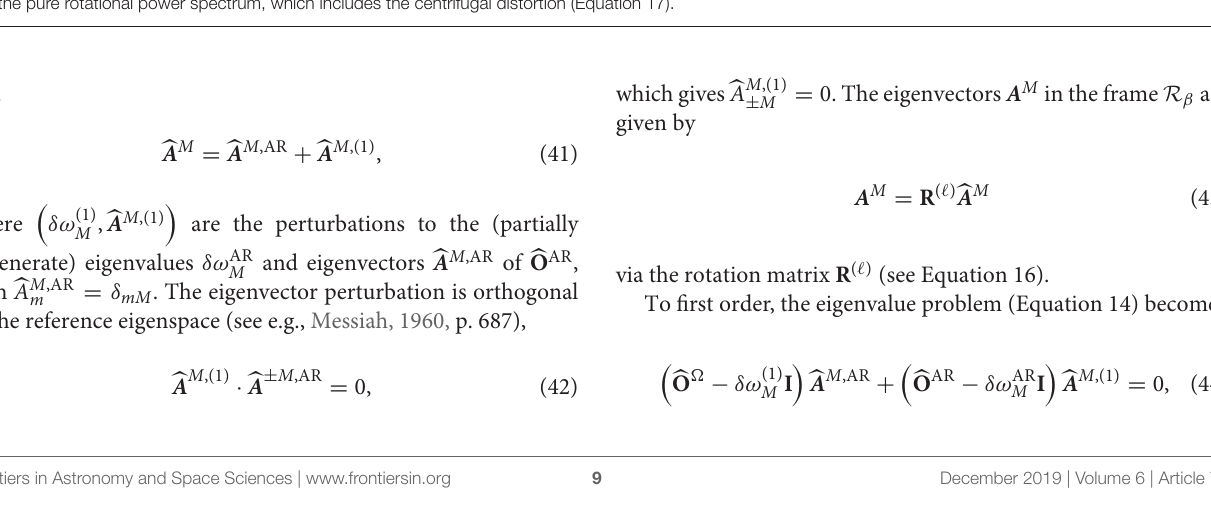
FIGURE 4 | Oscillation power spectra for the ( ℓ , n ) = (2,18) multiplet observed at two inclination angles i = 30 ◦ (A,C) and 80 ◦ (B,D) , for a star with a rotation period of 8 days and for an active region with ε n ℓ = 0.003, β = 20 ◦ (A,B) or 80 ◦ (C,D) , and for a surface coverage with α = 23 ◦ . The power spectra are normalized with respect to V 2 (Equation 33). The vertical line segments show the theoretical frequencies and amplitudes for the M = ± 1, ± 2 modes (black) and the M = 0 mode (red). The envelopes of the power spectra (solid black curves) are obtained by summing over Lorentzians with widths of 1 µ Hz. The dashed black curve shows the envelope of the pure rotational power spectrum, which includes the centrifugal distortion (Equation